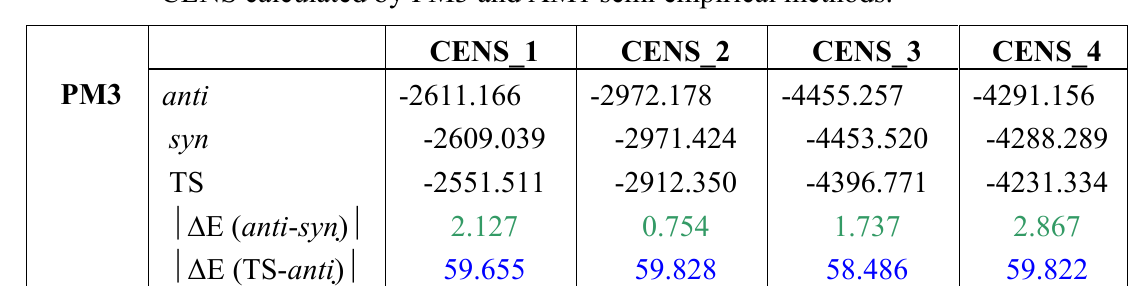
Table 6: The relative energy (kcal/mol) of the anti , syn and TS structures of the four CENS calculated by PM3 and AM1 semi empirical